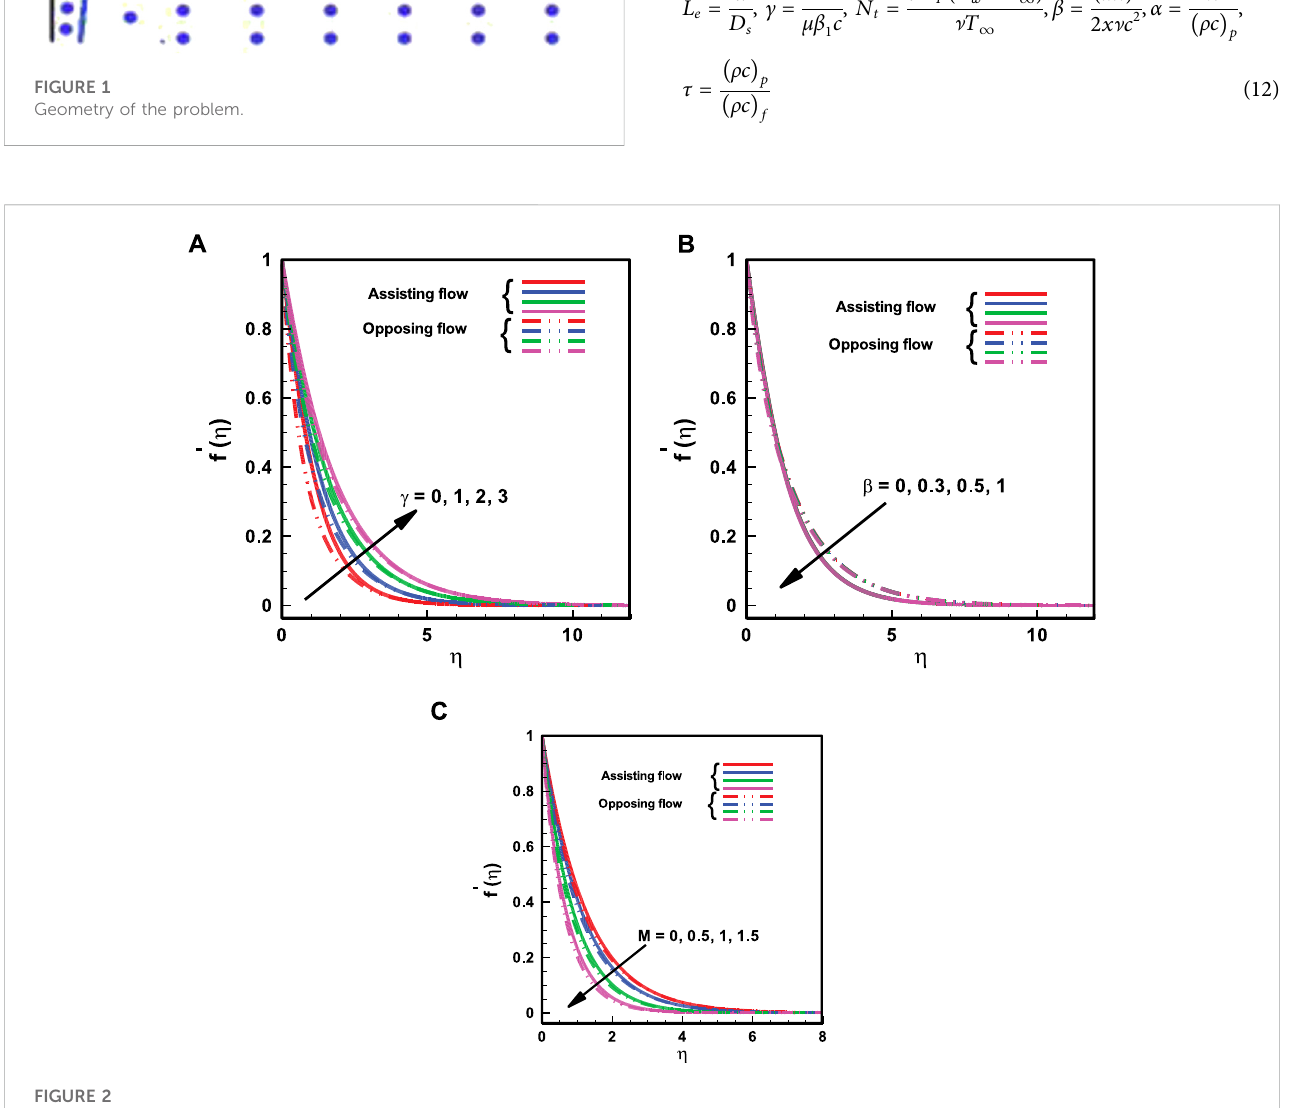
FIGURE 2 Plot of velocity pro fi le for (A) γ , (B) β and (C) M .